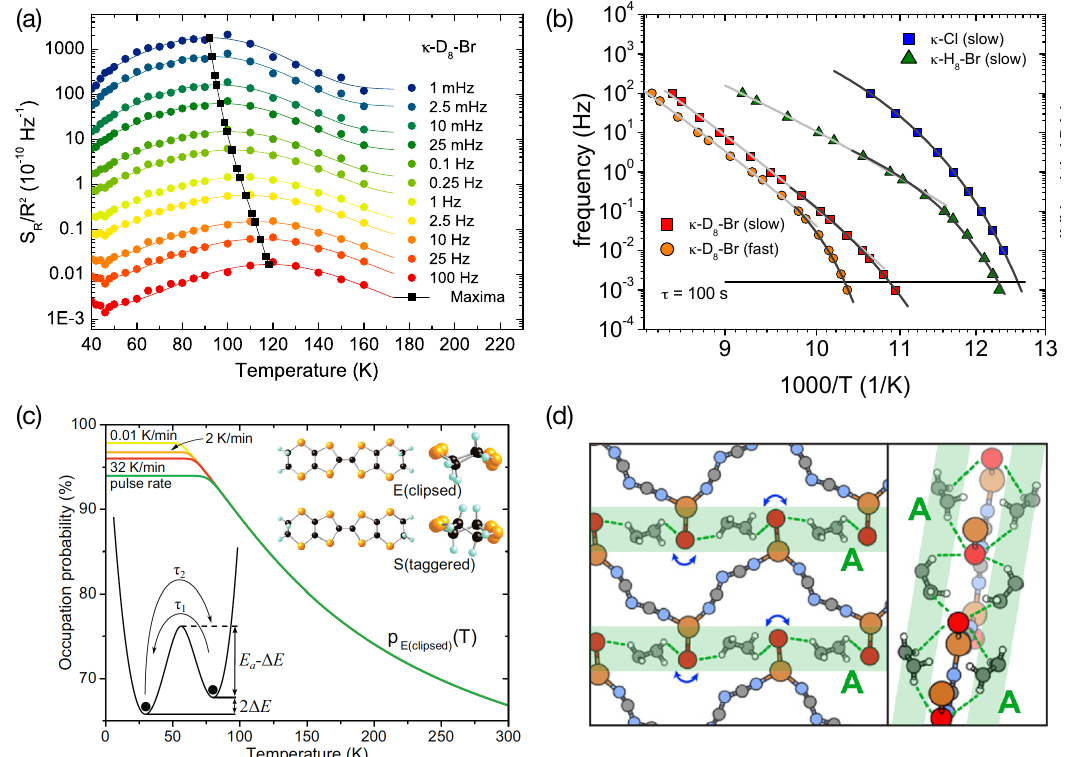
Figure 8. Glass-like structural EEG ordering in κ -(ET) 2 X. ( a ) normalized resistance noise PSD of κ -D 8 -Br for different frequencies. Lines are fits to a Gaussian function. Black circles connect the maxima at each frequency; ( b ) Arrhenius plot of the noise peak frequency for selected systems of κ -(ET) 2 X (see legend). Light grey lines are fits of thermally activated (Arrhenius) behavior to the high-frequency data, whereas dark grey lines are Vogel-Fulcher-Tammann (VFT) fits after Equation(19) to the low-frequency data. The horizontal line equals τ = 100s and may be used to define the dynamic glass-transition temperature; ( c ) occupation probability p ( E ) of the eclipsed (E) ground state conformation (see right inset) calculated from a simple two-level model (left inset) for various cooling rates. ’Pulse rate’ refers to cooling after a heat pulse is applied resulting in cooling rates of order 1000K/min. Reprinted with permission from [23]. Copyright (2014) by the American Physical Society; ( d ) preferred conformations of the EEGs for κ -Br in relation to the nearby anion layer. Dashed lines indicate close EEG Br contacts, while blue arrows indicate soft vibrational degrees of freedom of the · · · terminal Br ligands suggested to couple to the EEG rotation. In κ -Br, all EEGs are crystallographically equivalent. ( a , b , d ) reproduced from [93]. Copyright IOP